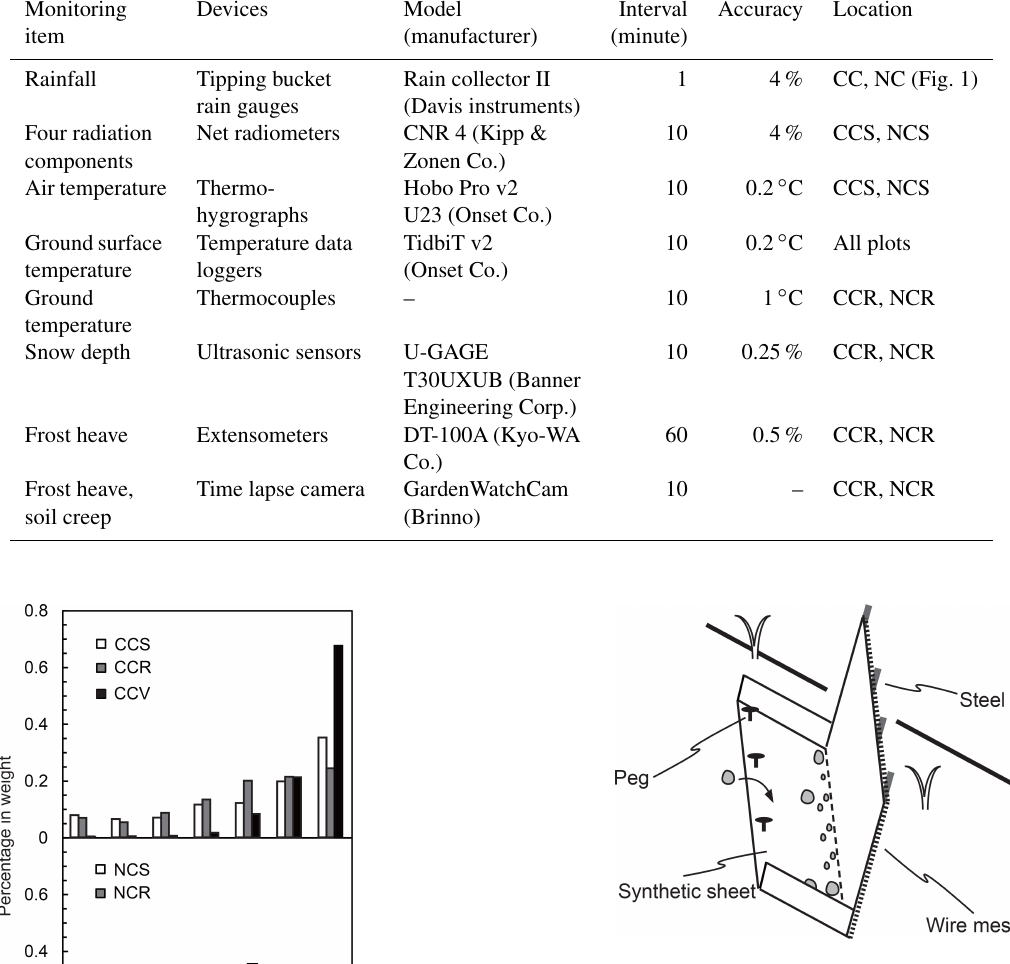
Figure 3. Illustration of sediment